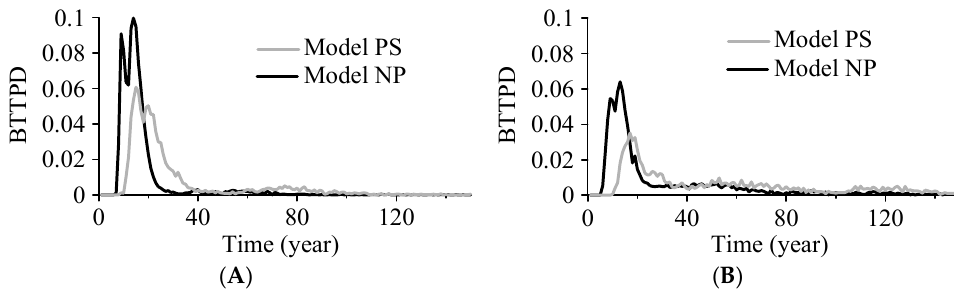
Figure 9. Simulated BTTPD for 2 wells located at different locations in Model PS (the original model with paleosol) and Model NP (the model without paleosol). ( A ) Represents the BTTPD for the well shown by the small rectangle in Figure 8A–D, where the well is above the second paleosol layer. ( B ) represents the BTTPD for the well shown by the small triangle in Figure 8E–H, where the well is below the second paleosol layer.